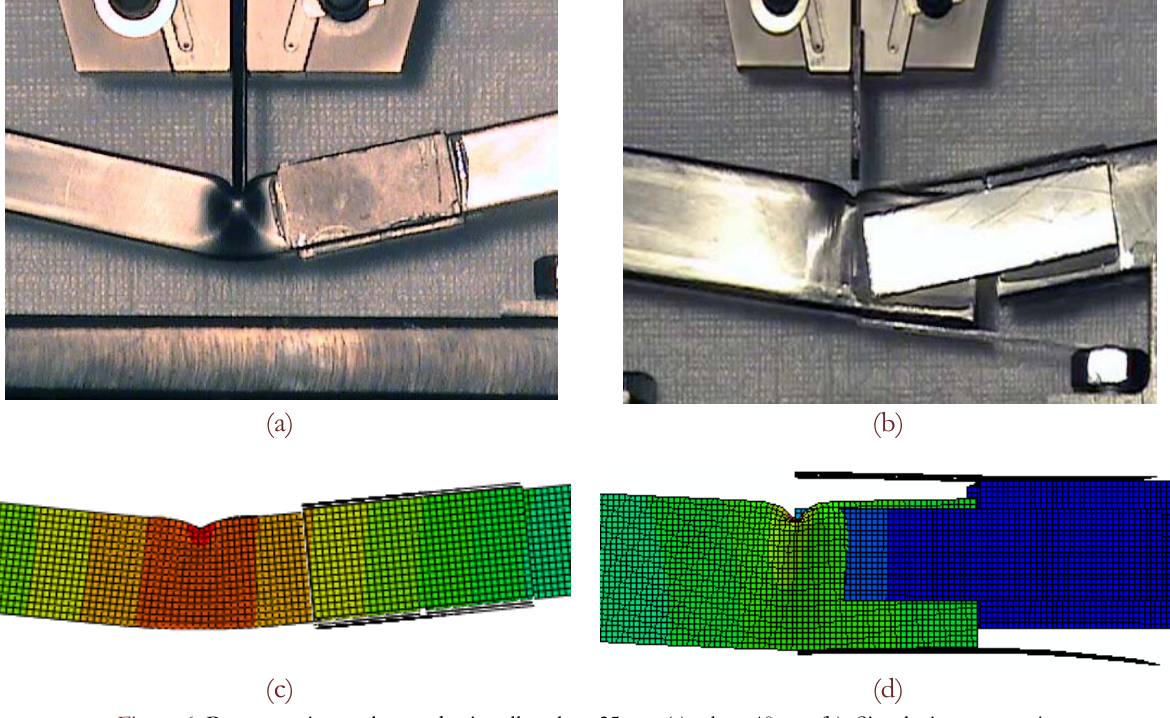
Figura 6: Prova sperimentale su tubo incollato lato 25mm (a) e lato 40mm (b). Simulazione numerica (mappa degli spostamenti) del tubo incollato lato 25mm (c) e lato 40mm